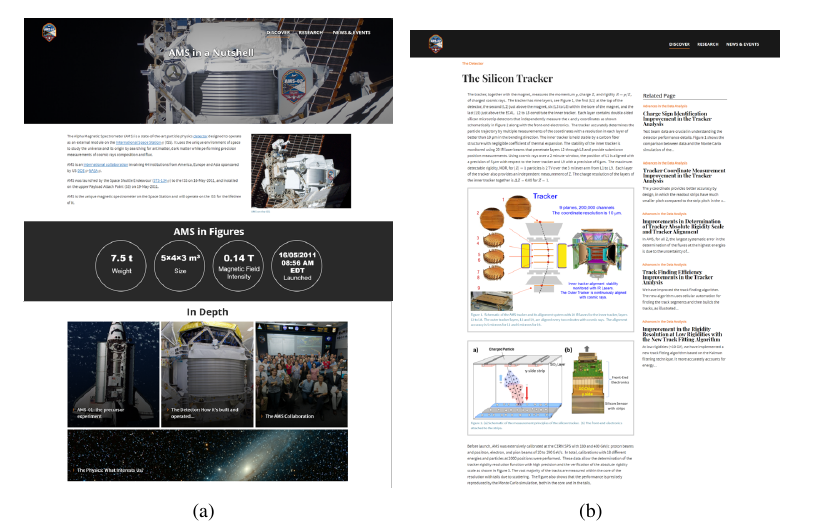
Figure 3. Two snapshots of the AMS theme. Page (a) is an introduction page with dedicated design using the Paragraph module. This module enables site builders to use predefined Paragraph Types to order contents in a page. Page (b) is generated by the Display Suite module where a common template is applied to all similar pages.